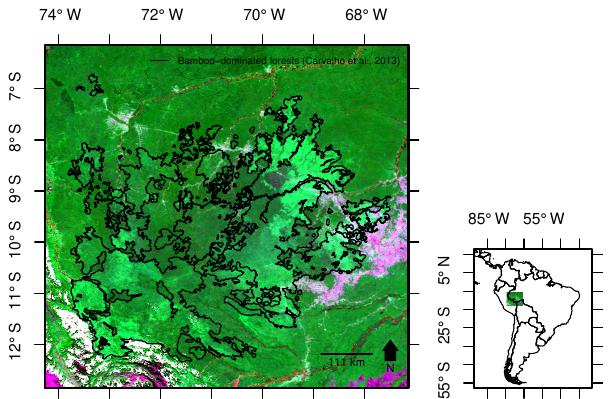
Figure 2. Bamboo-dominated forests in the southwestern Ama- zon. The image in the background is a false-color composite from MODIS (MAIAC) images of bands 1 (red), 2 (NIR) and 6 (short- wave infrared), in RGB, respectively, in August 2015. The black lines indicate the perimeter of the bamboo-dominated areas delin- eated in a previous study (Carvalho et al.,